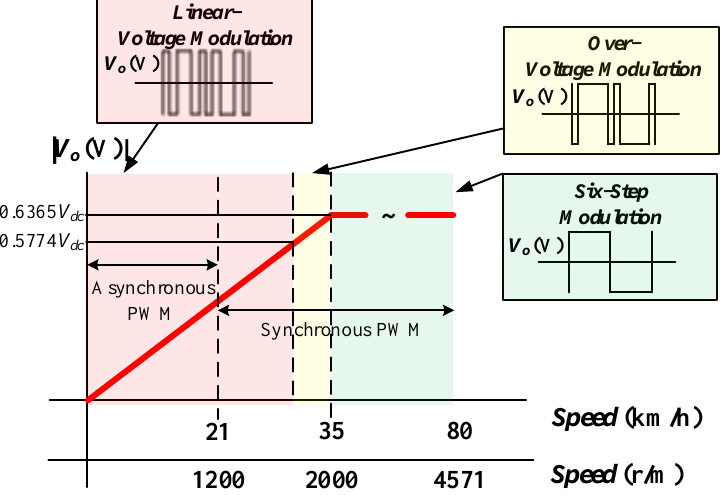
Figure 2. The output voltage ( V o ) of SiC inverter depending on the speed of railway vehicle.